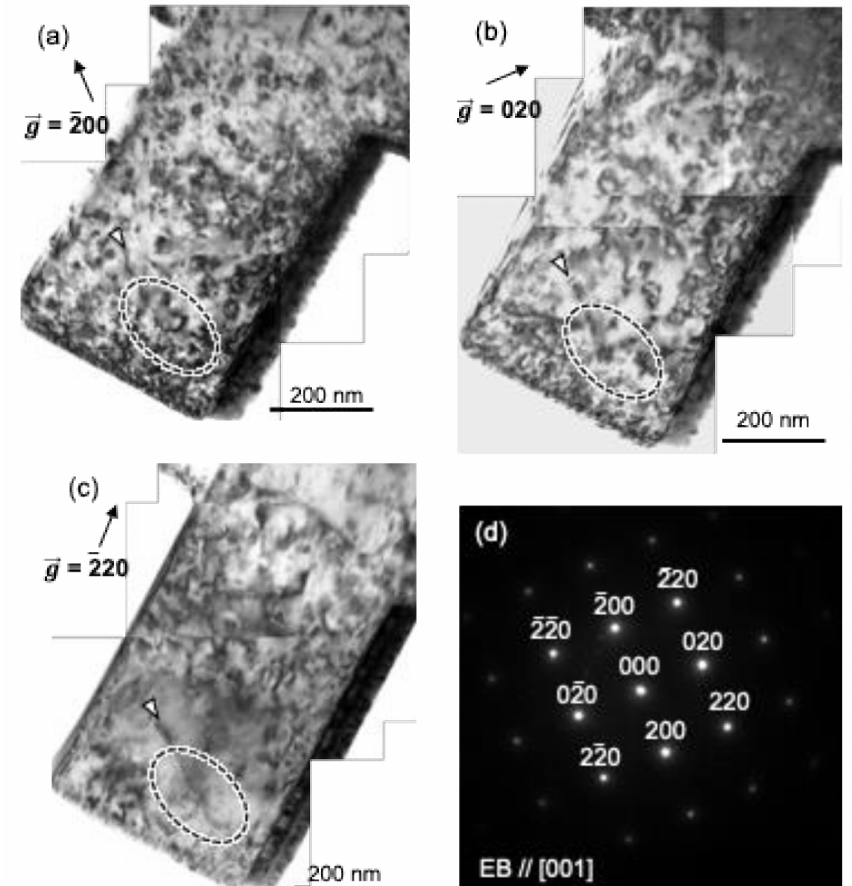
Figure 1. ( a – c ) Bright field images showing the defects induced by the focused ion beam (FIB) process in the as-FIB Al pillar. The images were taken under a near-two-beam condition with the diffraction → → → → g , ( a ) g = 200, ( b ) g = 020, and ( c ) g = 220. ( d ) Selected-area electron diffraction pattern of vector the Al pillar shown in ( a – c ). The incident electron beam was parallel to [001]. Dashed ellipse and → b = 1/3 (cid:104) 111 (cid:105) and dislocation with white arrows represent positions existing dislocation loop with → b = 1/2 (cid:104) 110 (cid:105)